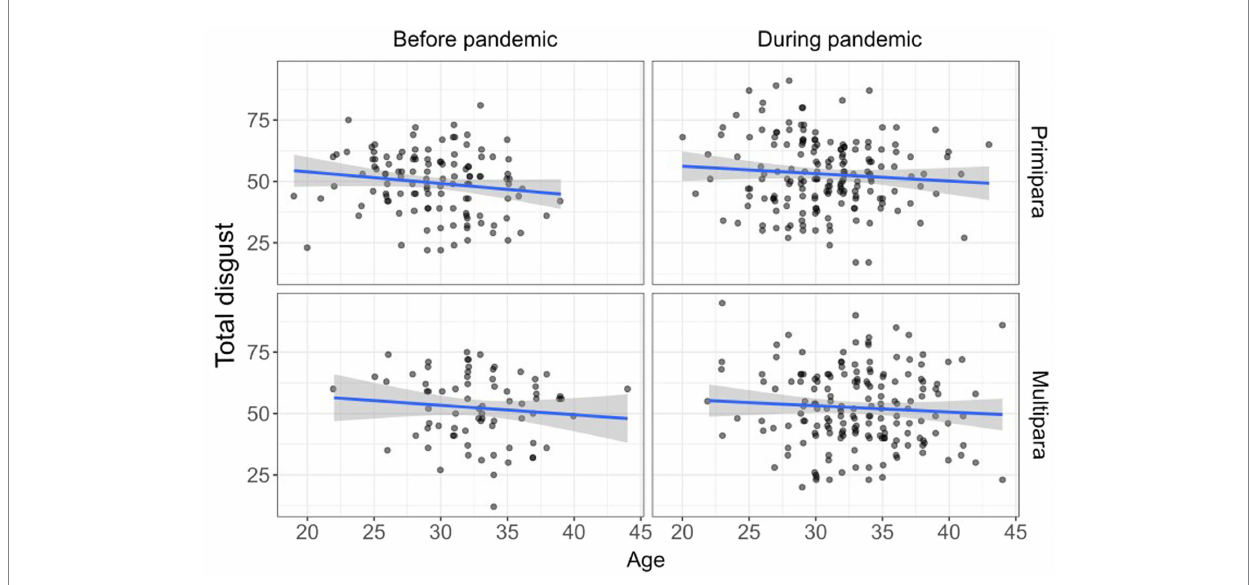
FIGURE 2 Effect of age on disgust sensitivity in pregnant women before and during the COVID-19 pandemic — Stratified by parity (fitted line for regression, confidence bands).